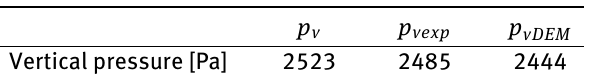
Figure 8: Dependence of the total force acting on the storage con- tainer bottom Table 5: Comparison of vertical pressure acting on the storage container